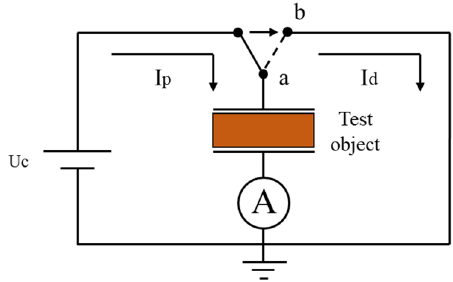
Figure 4. Schematic diagram.